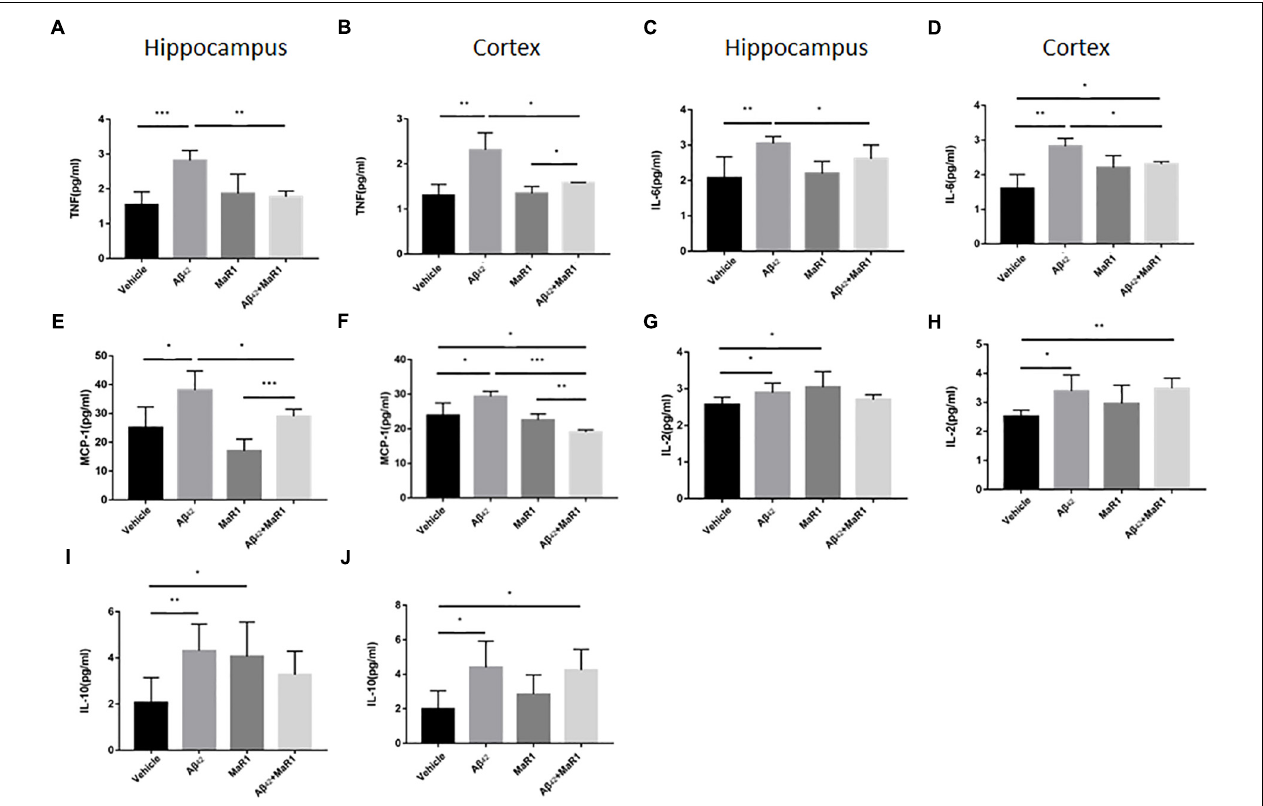
FIGURE 4 | Effects of MaR1 on the secretion of inflammatory cytokines. ELISA and CBA analysis for different inflammatory mediators in the hippocampus and cortex, TNF (A,B) , IL-6 (C,D) , MCP-1 (E,F) , IL-2 (G,H) , IL-10 (I,J) . (A–F) The levels of TNF- α , IL-6 and MCP-1 in A β 42 group were significantly higher than those in Vehicle group ( P < 0.05), while treatment of A β 42 + MaR1 significantly decreased the levels of TNF- α , IL-6 and MCP-1 induced by A β 42 ( P < 0.05). (G–J) The levels of IL-2 and IL-10 in A β 42 group were significantly higher than those in Vehicle group ( P < 0.05); MaR1 treatment increased the production of IL-2 and IL-10 in the hippocampus ( P < 0.05); the levels of IL-2 and IL-10 in A β 42 + MaR1 group were higher than those in Vehicle group in the cortex ( P < 0.05). Data are expressed as mean ± SEM, 10 mice in each group, and statistical significance is defined as follows: ∗ P < 0.05, ∗∗ P < 0.01, ∗∗∗ P <